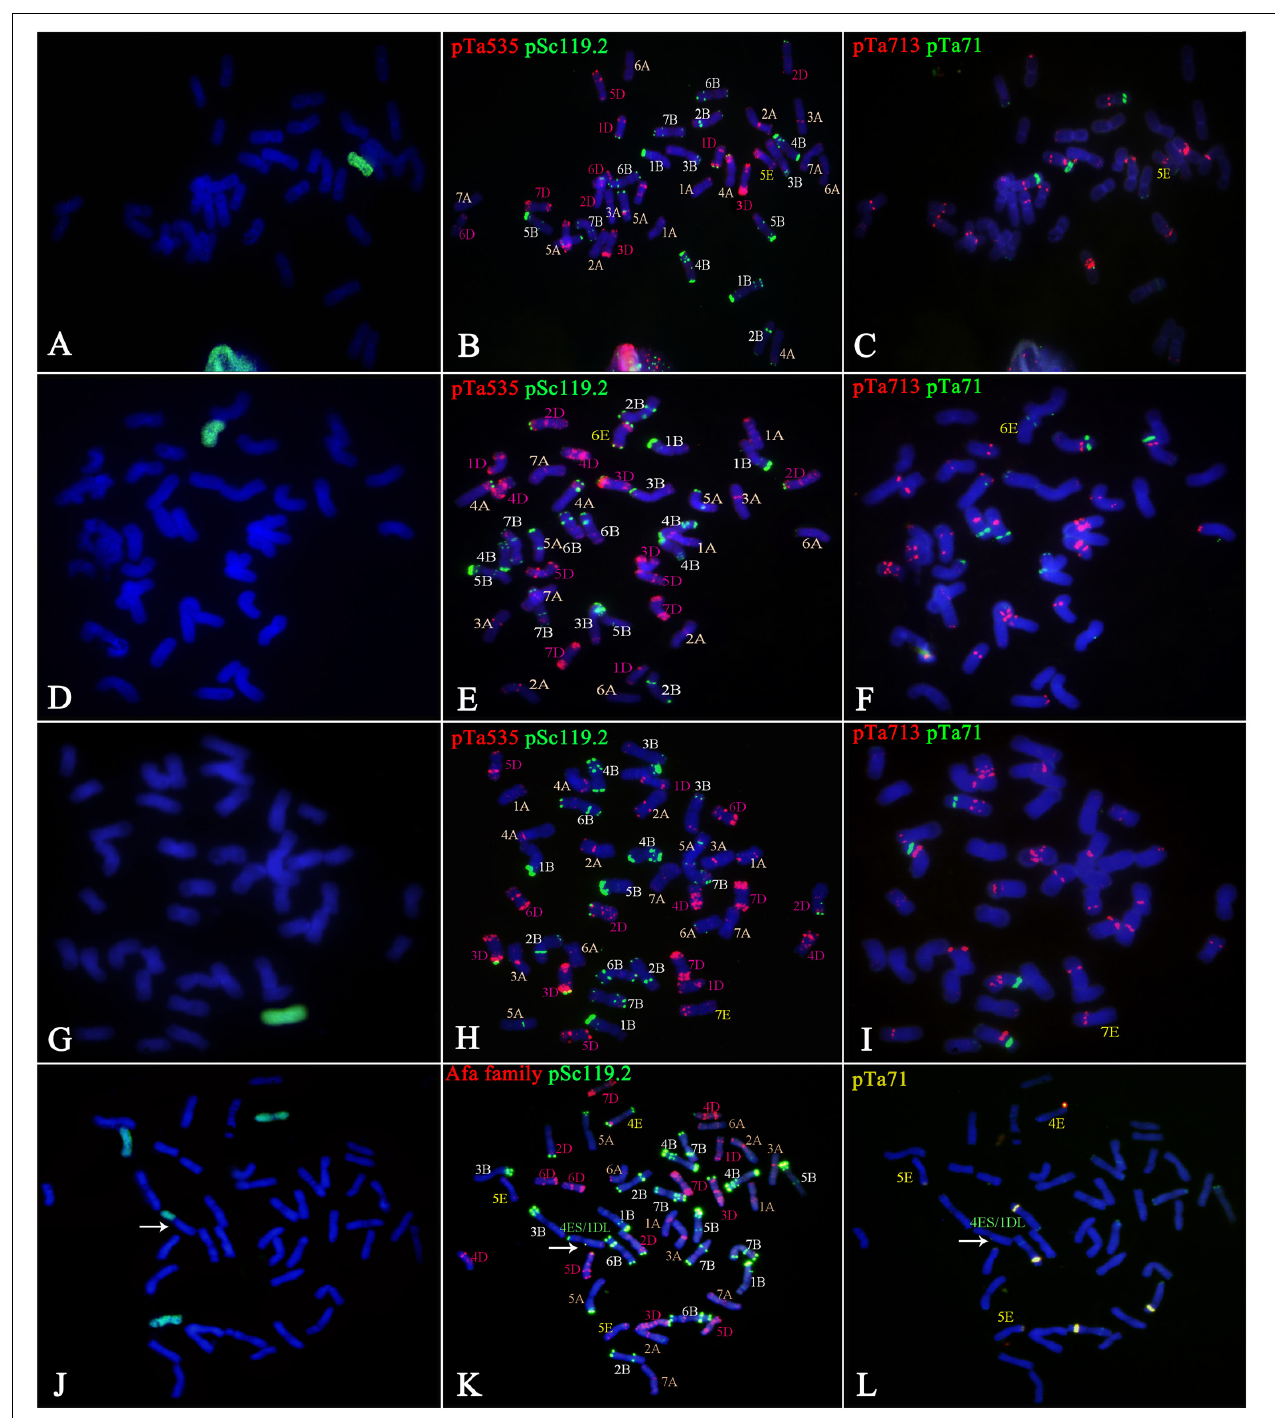
FIGURE 5 | Chromosome identification of the hybrid progenies. Images on the right of each panel show FISH results using pSc119.2 (green), pTa535 (red), pAs1 (red), pTa713 (red), and pTa71 (green), and those on the left show corresponding GISH patterns. Chromosomes in blue and green are wheat and Th. elongatum chromosomes in the GISH patterns, respectively. (A–C) Line K17-1084-3 had a complete set of 28 A/B chromosomes, 12 D (lacking one 4D and 5D) chromosomes, and one 5E chromosomes. (D–F) Line K17-1065-5 had 14 A, 15 B (plus one 4B), 12 D (1D-5D, 7D), and one 6E chromosomes. (G–I) Line K16-2521-1-2 had a complete set of wheat chromosomes and one 7E chromosomes. (J–L) K15-1033-8-2 had 12A (1A-3A, 5A-7A), 16 B (four 7B), 13 D (lacking one 1D), 3 E (one 4E and two 5E), and one 4ES1DL translocation chromosomes (arrow).